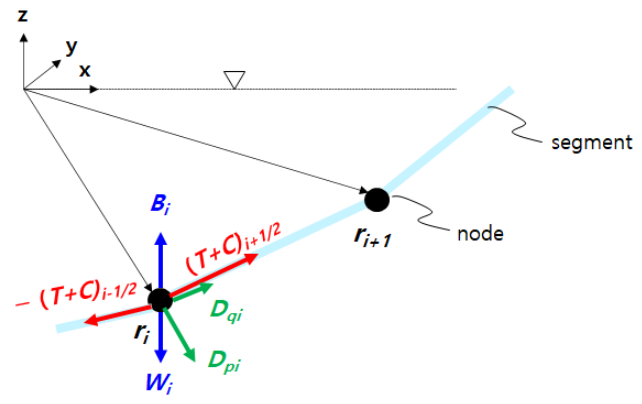
Figure 1. Internal and external forces acting on the nodes and segments. MoorDyn has three core functions. LinesInit( ), LinesCalc( ), and LinesClose( ) are related with initialization, calculation and closing modules, respectively. Using these core functions, it can be coupled with other simulation tools